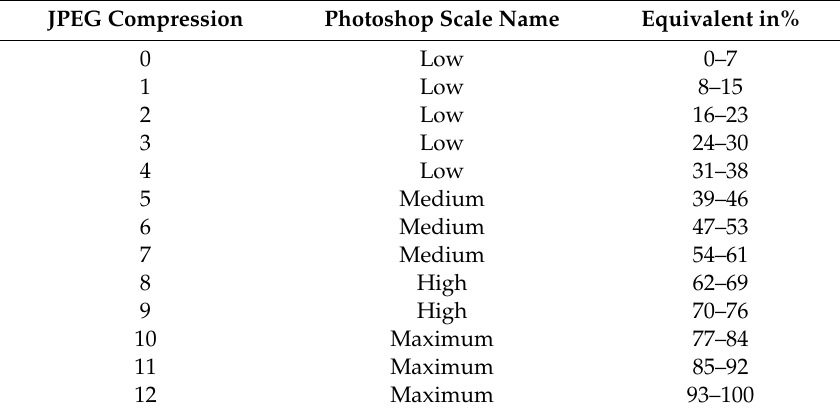
Table 1. Compression levels available in